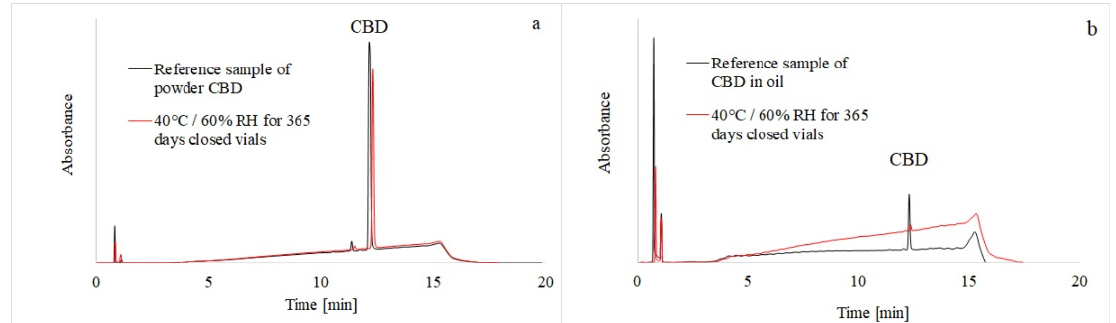
Figure 2. HPLC-UVchromatograms of CBD reference samples (black line) and CBD samples stored for 365 days (red line) in the stability chambers. The CBD powder was measured at 225 nm ( a ) and the CBD oil solution at 210 nm ( b ).